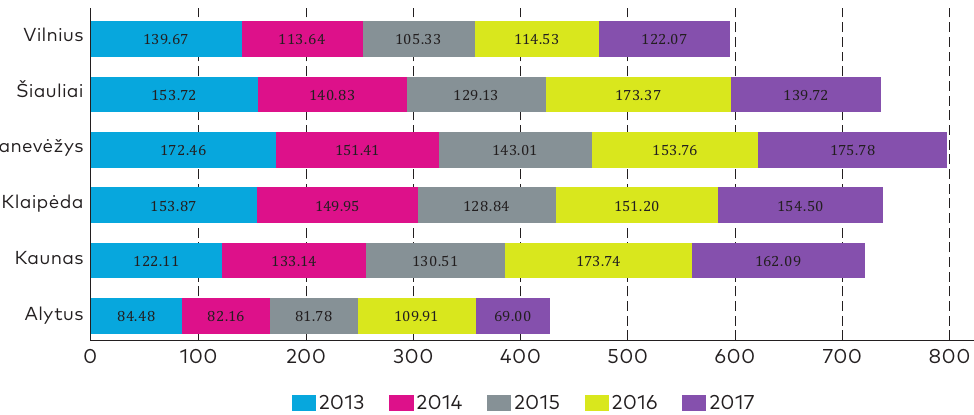
Figure 3. The number of recorded traffic injury accidents per 100 thousand inhabitants in the largest cities of Lithuania (Lithuanian Road Administration, n.